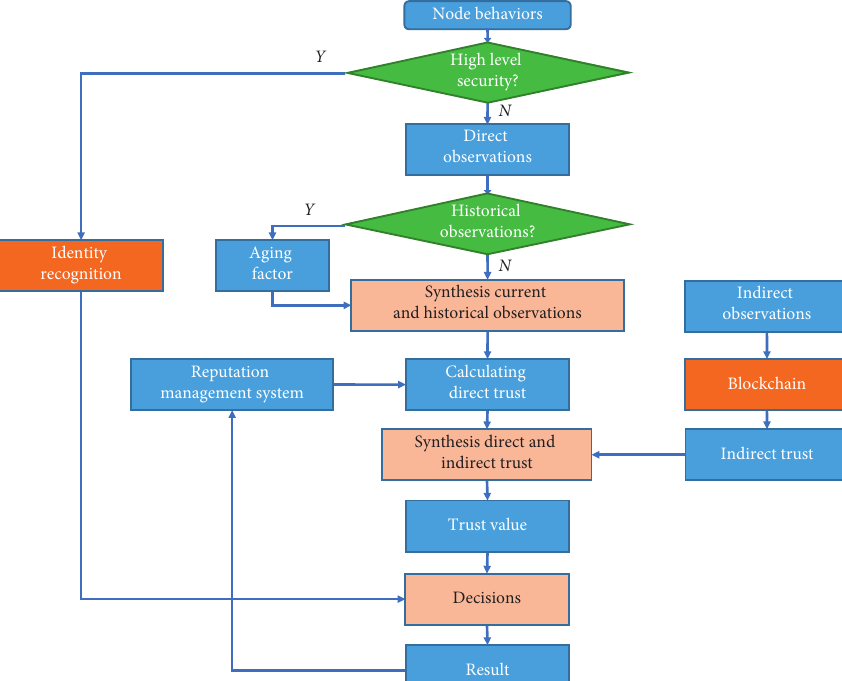
Figure 1: A hybrid scheme: identity recognition is used to satisfy requirements of high-level security, and blockchain is used to transmit indirect